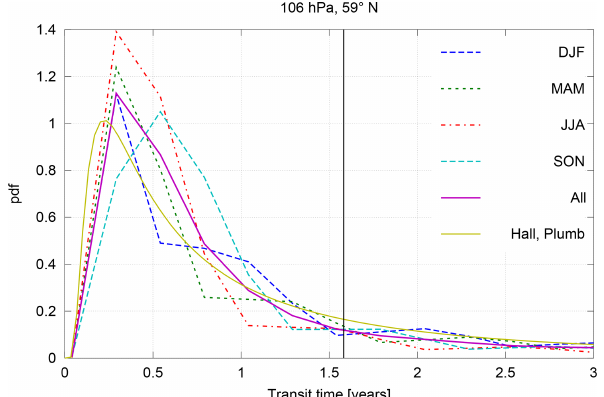
Figure 5. Age spectra at 59 ◦ N and 106hPa from the tranPul sim- ulation. The dashed lines are the seasonal mean spectra. The pink solid line is the annual mean age spectrum. The solid yellow line is the spectrum calculated from the Hall and Plumb parameterization using the values from the integration of the annual mean spectrum, that is, a mean age value of 1.6 years (vertical line) and a ratio of moments of 1.8 years (Eqs. 2 and